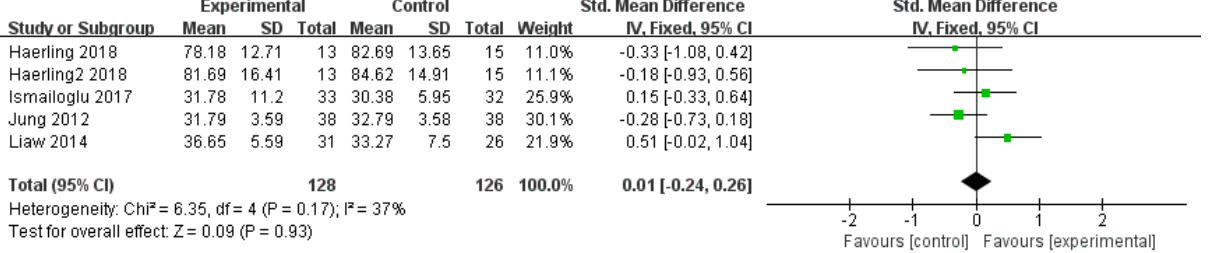
Figure 5. Forest plot of virtual reality on skills.